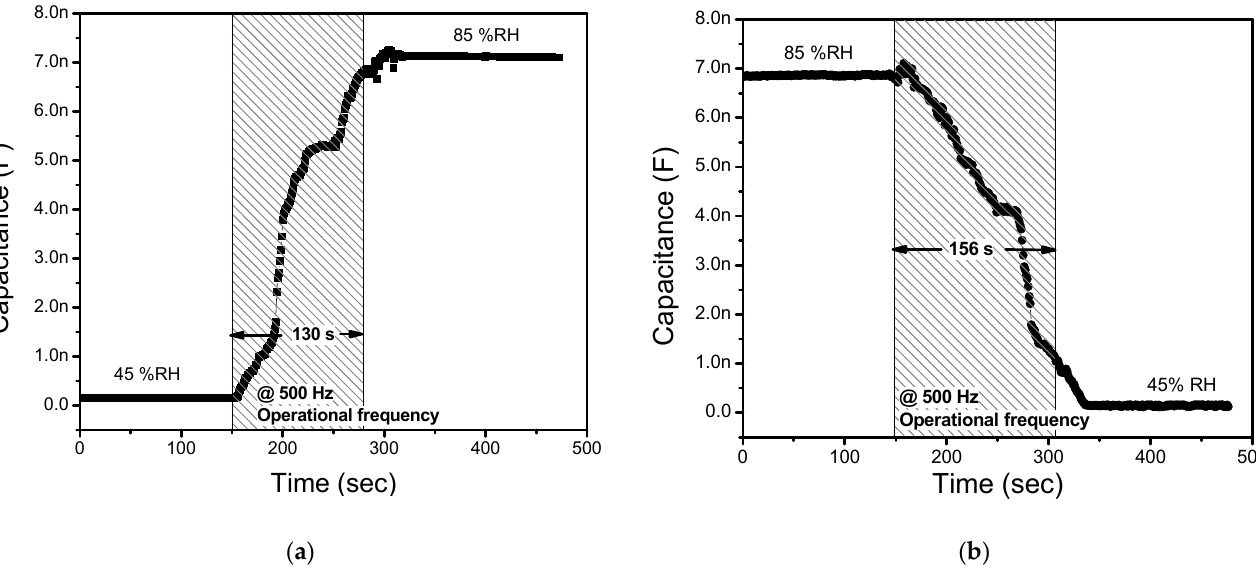
Figure 10. ( a ) Response and ( b ) reset time measurement of the proposed humidity sensor at 500 Hz test frequency.